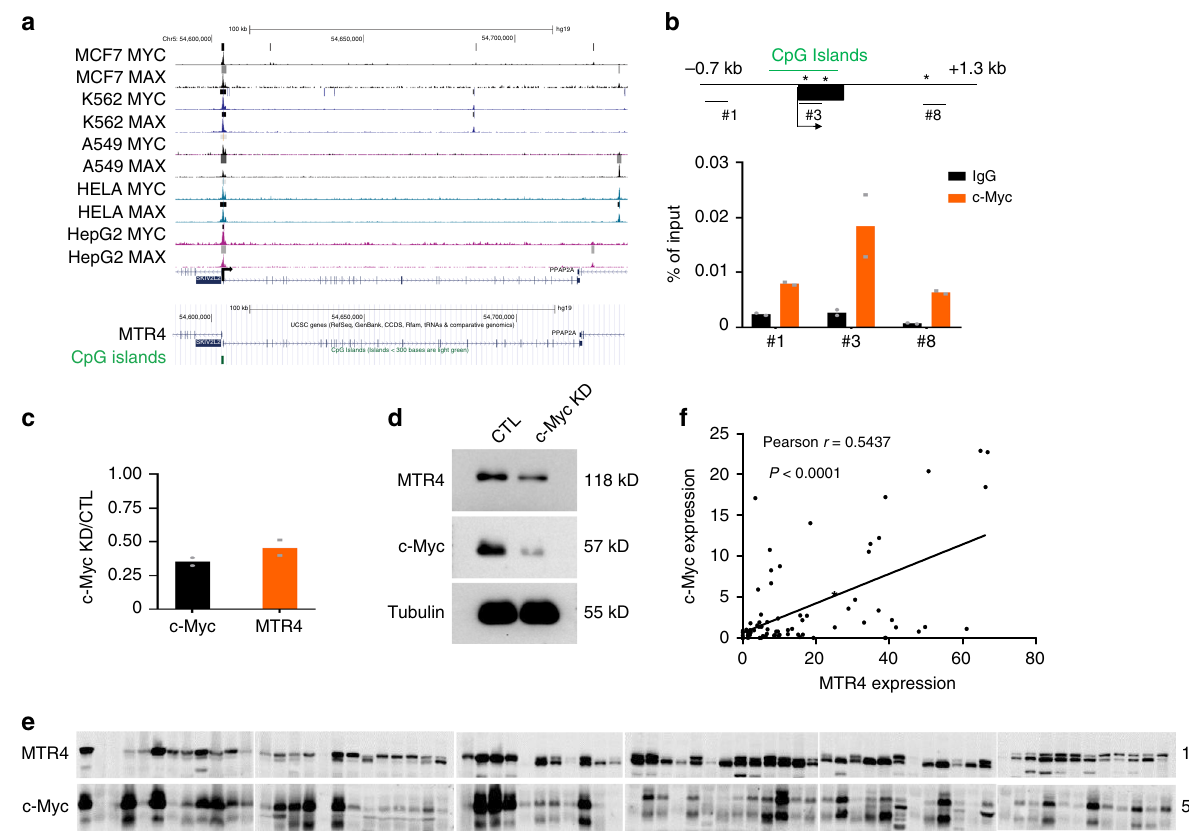
Fig. 6 MTR4 is a direct transcriptional target of c-Myc. a The analysis of Chip-seq data of c-Myc in human cancer cell lines available in the ENCODE database predicted that c-Myc binds to the promoter region of MTR4. b ChIP analysis of the binding of c-Myc to the predicted c-Myc binding sites within the MTR4 promoter. A schematic of MTR4 regulatory region ( − 0.7 to + 1.3 kb from TSS) was shown. Arrow and black rectangle represent the transcriptional start site (TSS) and exon1, respectively. * indicates the canonical E box. Green bar indicates CpG Islands. Numbers indicates the regions for PCR. Chromatin DNA fragments were immunoprecipitated with anti-c-Myc antibody or IgG. Data are presented as mean values. n = 2 independent experiments. c The mRNA levels of c-Myc and MTR4 were detected by q-RT-PCR and normalized by actin . Data are presented as mean values. n = 2 biologically independent samples. d The protein levels of c-Myc and MTR4 after the knockdown of c-Myc in HCC cells. Representative data from two independent experiments are shown. e , f The protein levels of c-Myc and MTR4 in HCC patient samples were analyzed by western blotting ( e ) and their correlation analyzed ( f ). The protein samples were run on multiple gels with one common sample run on all gels as a quantitative control. Two-tailed Pearson correlation test. p value and pearson ’ s correlation coef fi cient r are indicated. n = 68 HCC patient samples. Source data are provided as a Source Data fi